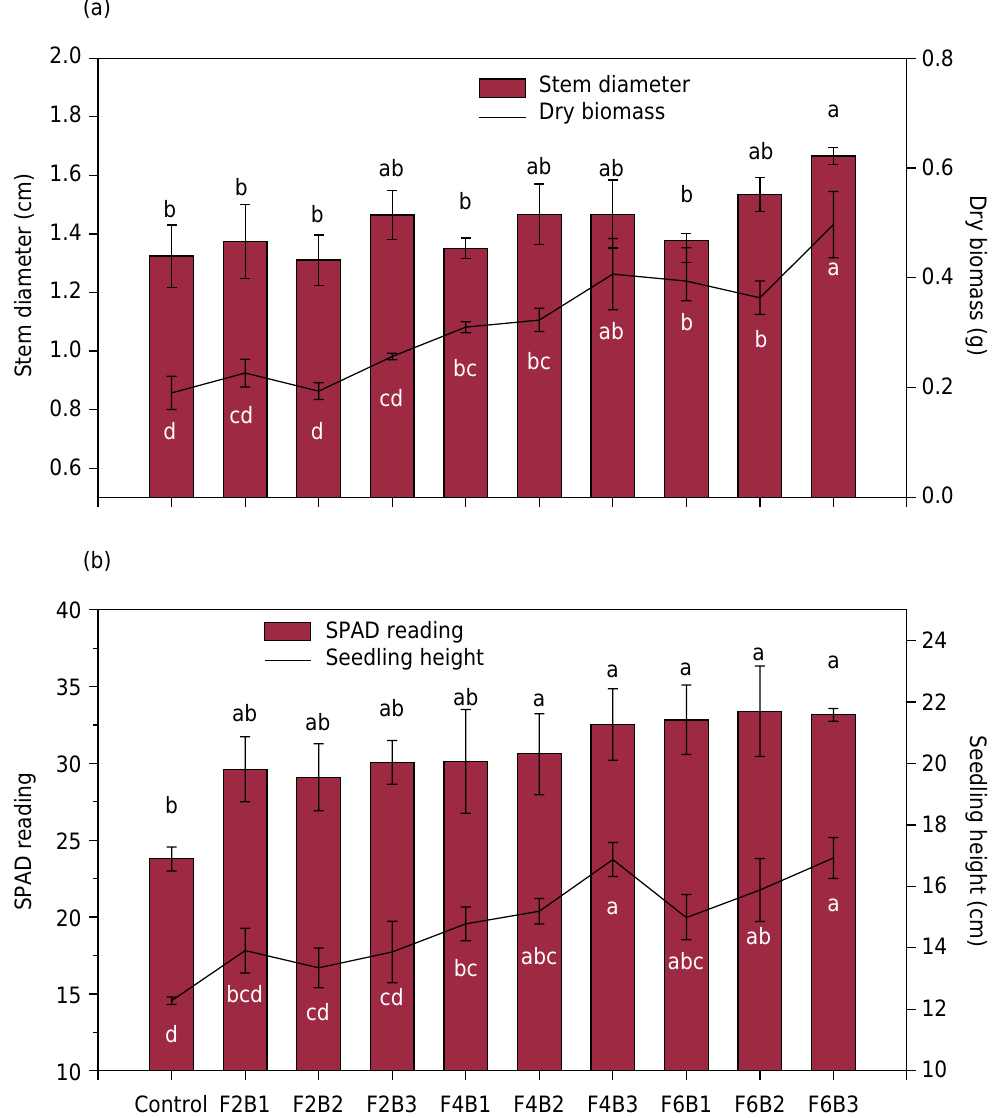
Figure 1. Stem diameter and dry biomass of corn seedlings in different treatments (a), SPAD reading and height of corn seedlings in different treatments